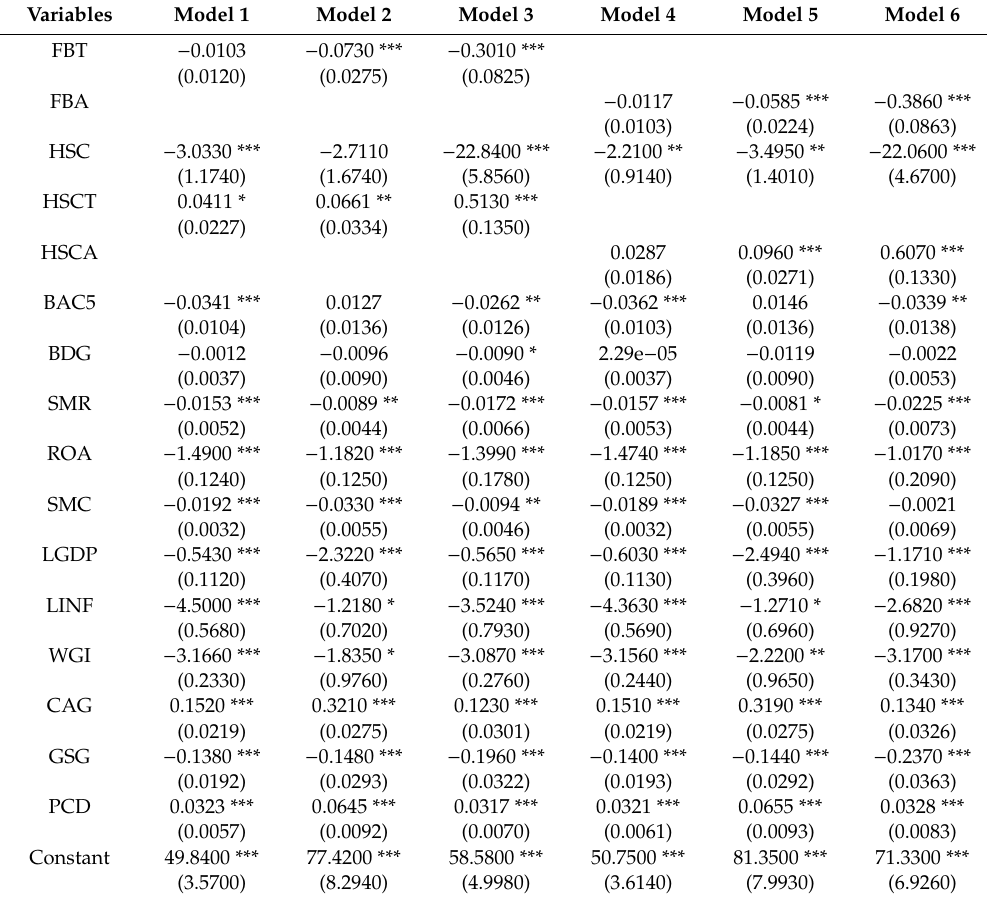
Table 4. Bank competition, foreign bank entry, and bank risk-taking behavior